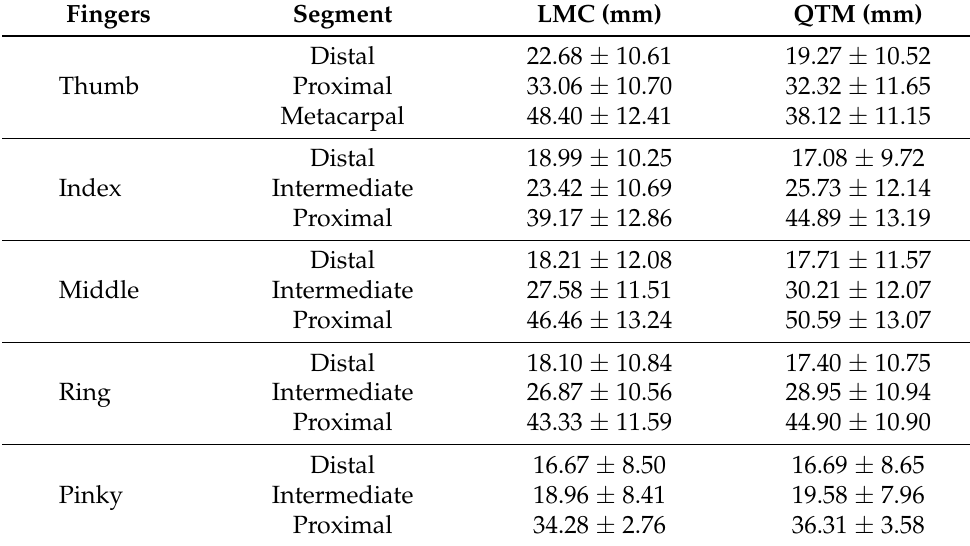
Table 1. Overall mean ± the s.d. of the segment lengths of ten